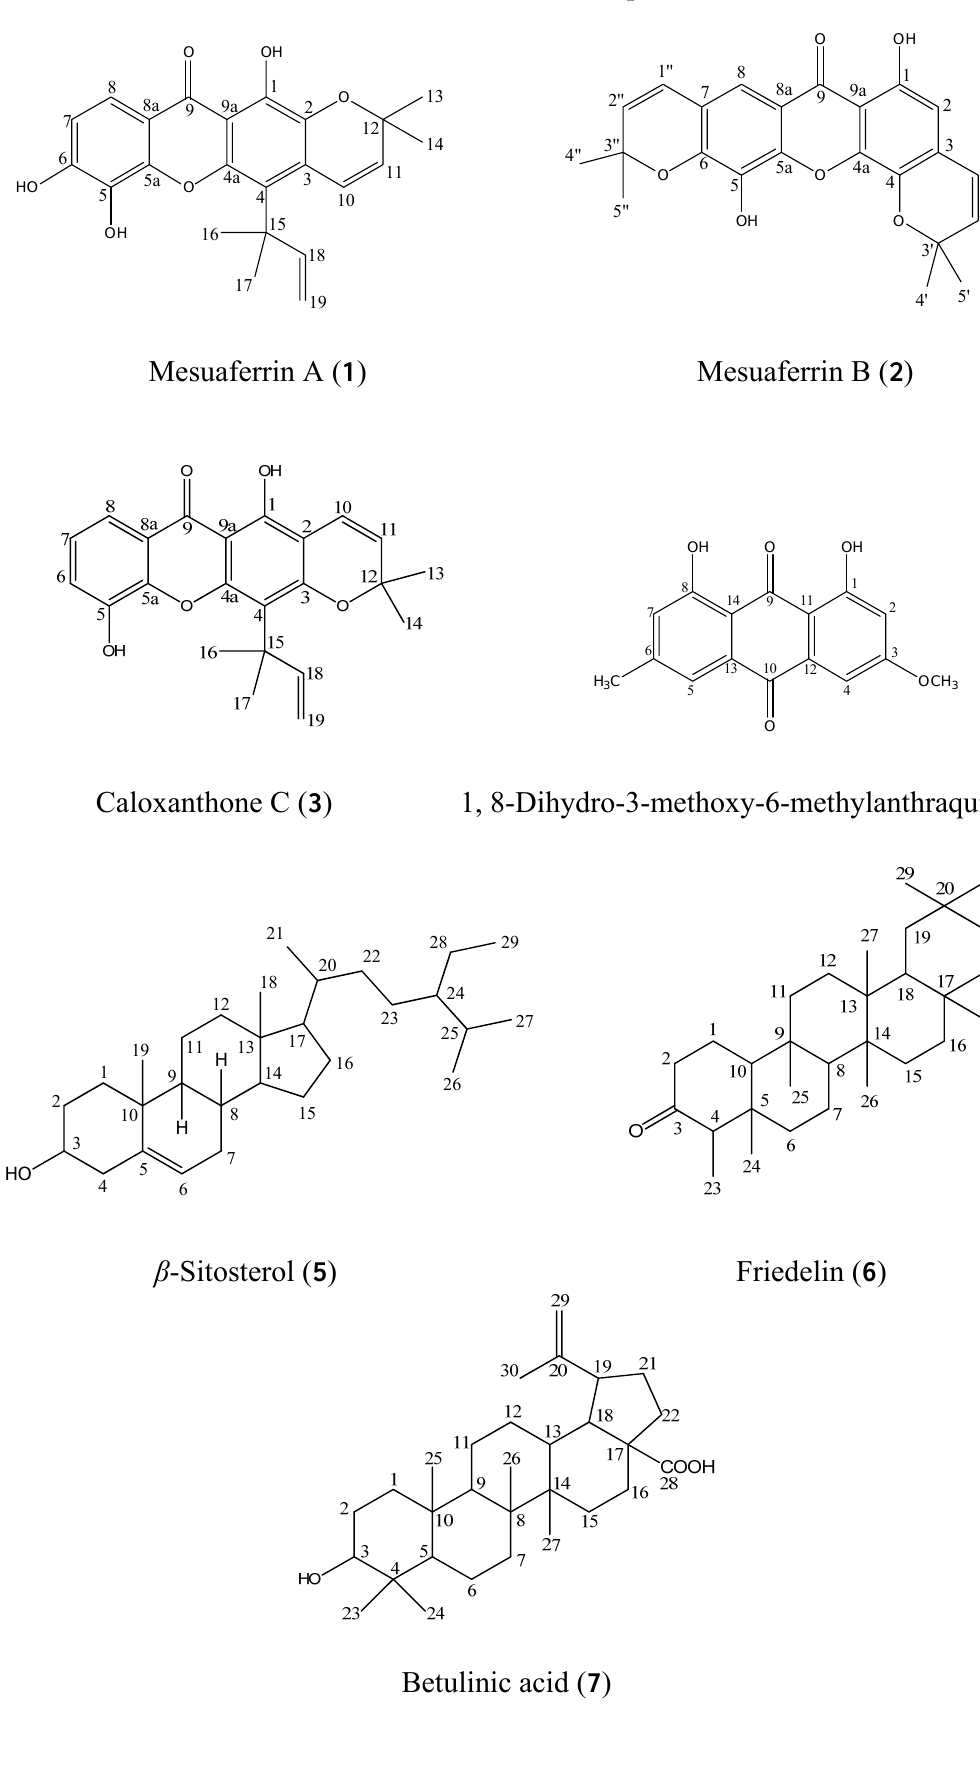
Figure 1. Structures of